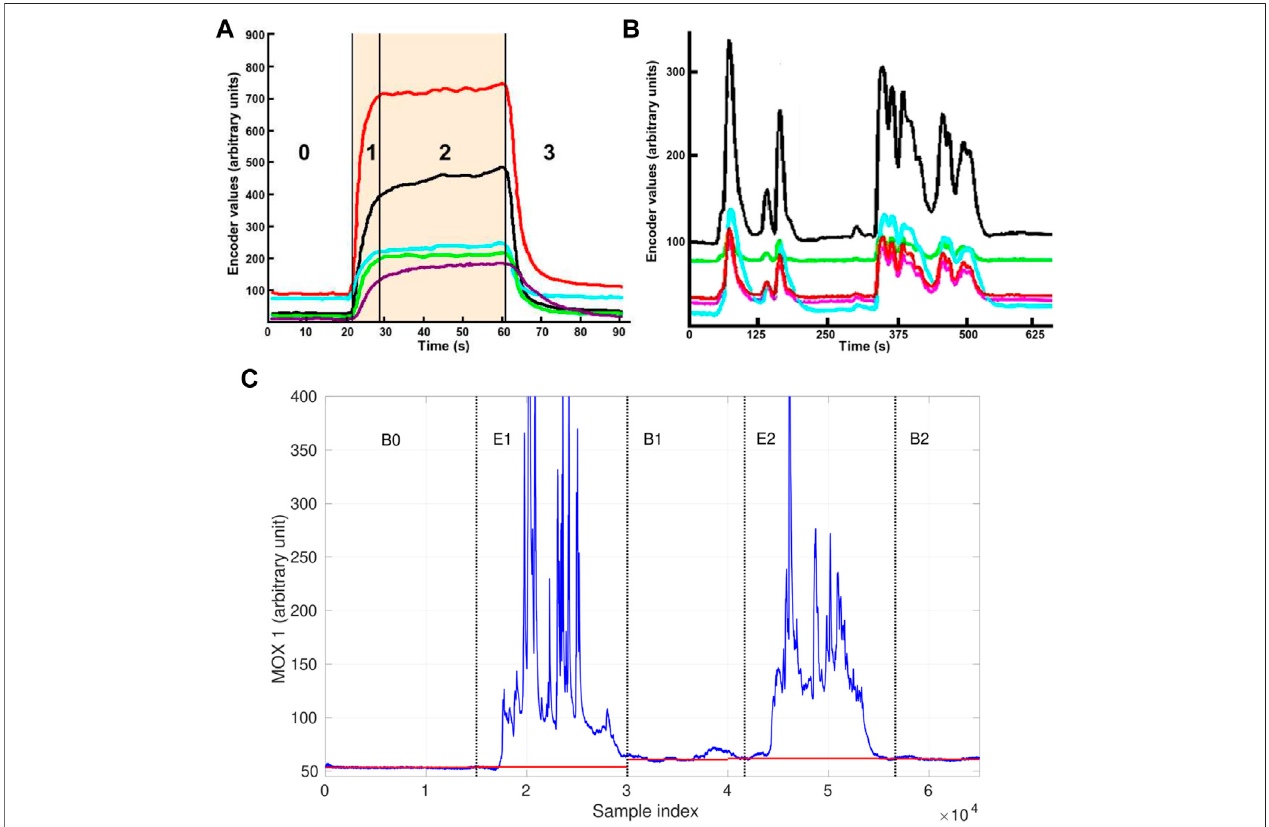
FIGURE 2 | Responses patterns acquired with MOX sensor arrays with different sampling processes. (A) An example of the three-phase sampling process. The numbers in the fi gure indicate the stages of the sensor responses, namely 0-baseline response, 1-rising edge, 2-steady state, 3-recovery edge. The shaded area denotes the period of time during which the sensors are exposed to the chemical analyte, and each color represents the response of a single sensor. (B) Response pattern acquired with an open sampling system. Both images are adapted from (Trincavelli et al., 2009) with the author ’ s permission. (C) An example of baseline drift of a MOX sensor response of an open sampling system. The red segments represent the observed baseline offsets that correspond to the sensor response level under clean air. The baseline offsets in the periods B1 and B2 are higher than the initial baseline offset in the period B0.